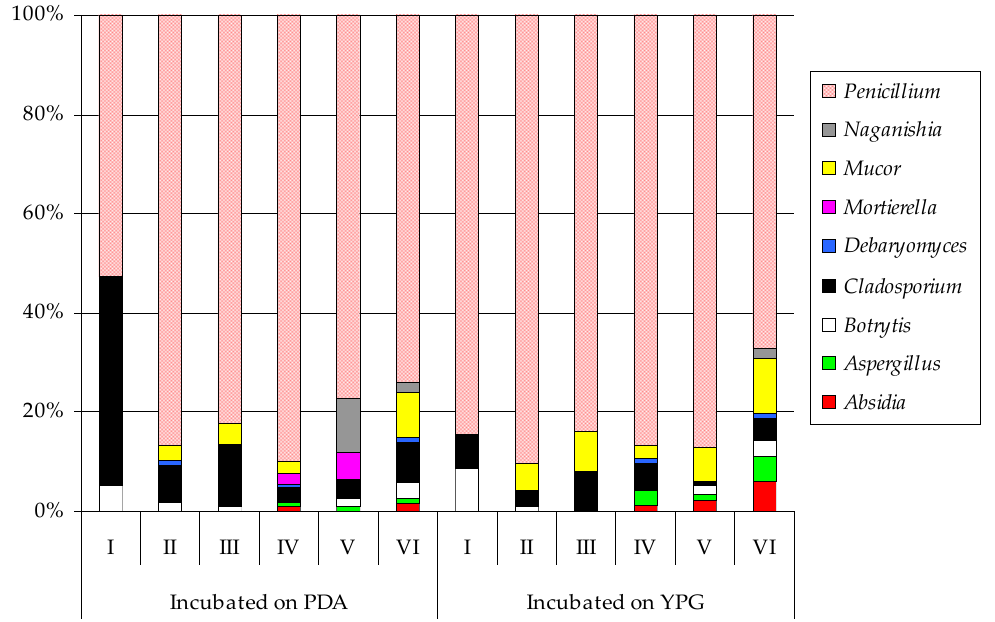
Figure 3. Percentage of each airborne fungal genus contributing to the total fungi cultured at 24 ± 0.5 °C in the underground hibernation sites in the Nietoperek bat reserve. Study site number I was outside the underground object and locations from II to VI inside it. The air sampler was positioned 1.5 m above the level of the floor at study site numbers from I to III, and it was positioned at a distance of 0.7–1 m from clusters of M. myotis in locations from IV to VI.